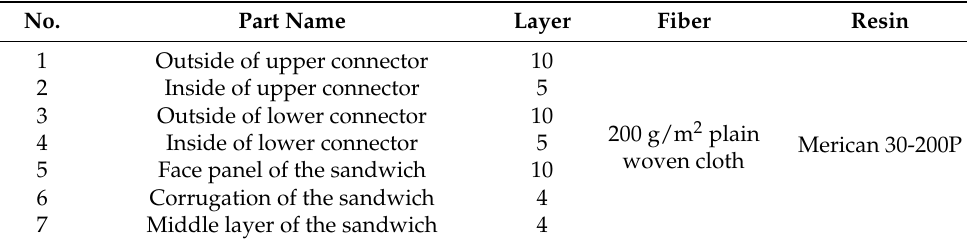
Table 1. Layout of connectors.